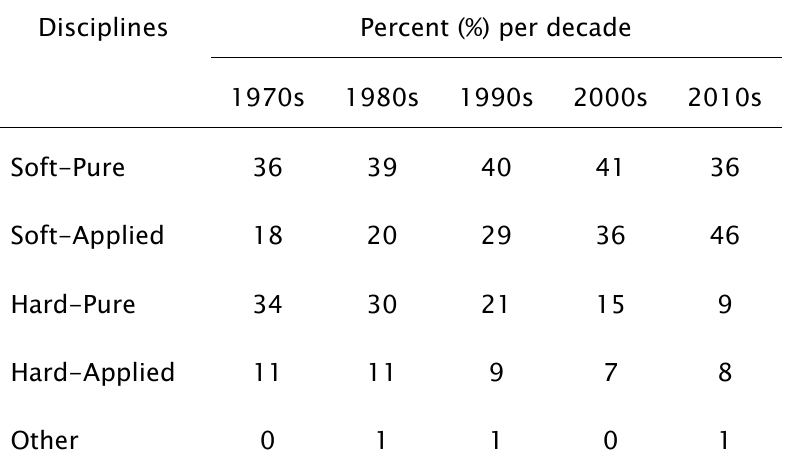
Respondents Who Achieved Their Doctorate, per Disciplinary Group, by